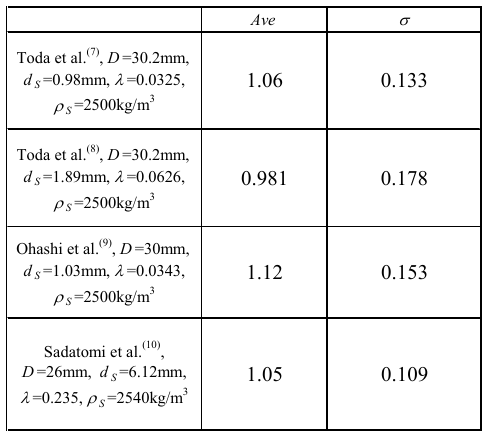
other researchers